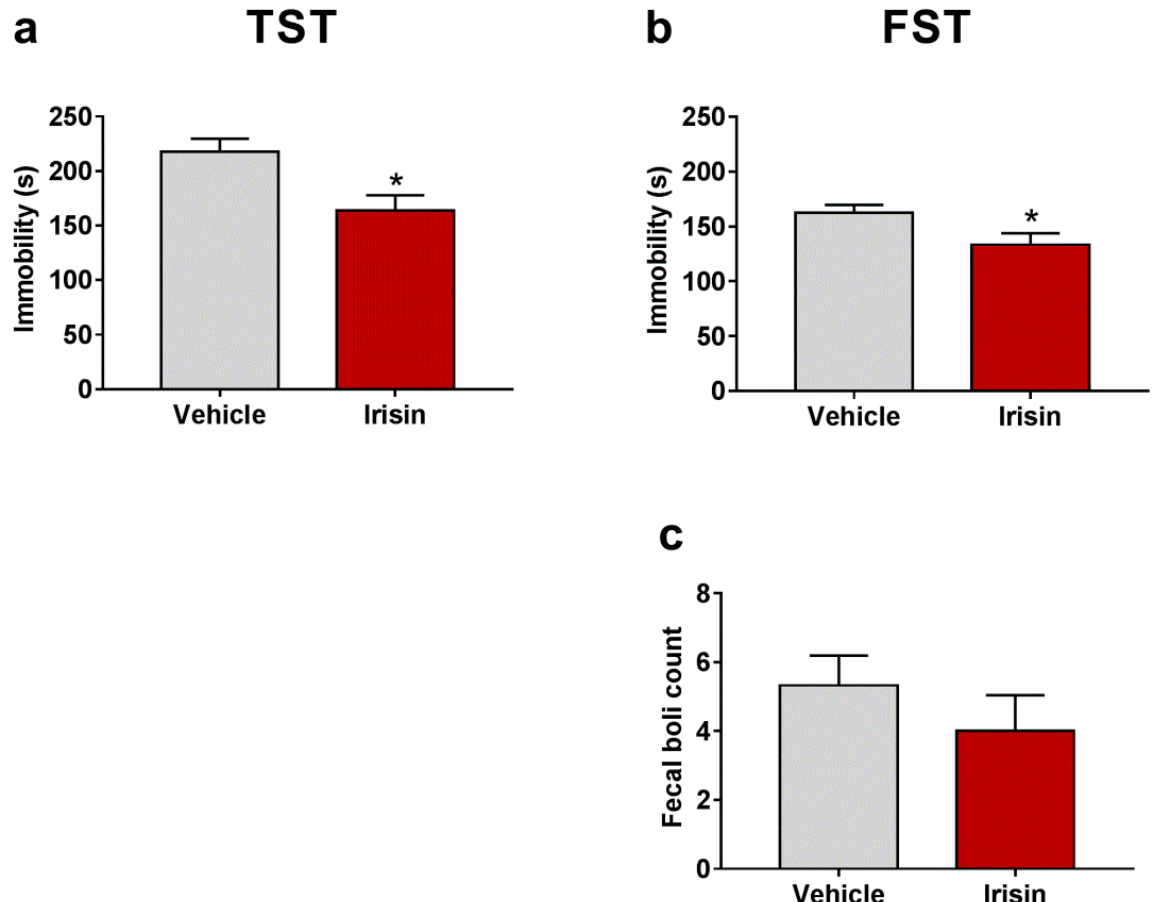
Figure 1. Effect of irisin long-term systemic administration on the immobility time in the TST ( a ) and in the FST ( b ). Number of fecal boli excreted in the FST test ( c ). Histograms represent mean values ± SEM. Unpaired two-tailed Student’s t -test was used for statistical analysis. * p < 0.05.